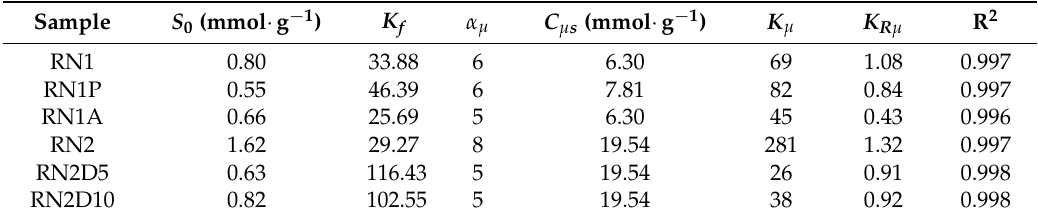
Table 8. Do-Junpirom-Do (DJD) parameters for the water vapor adsorption isotherms at 30 ˝ C of the studied